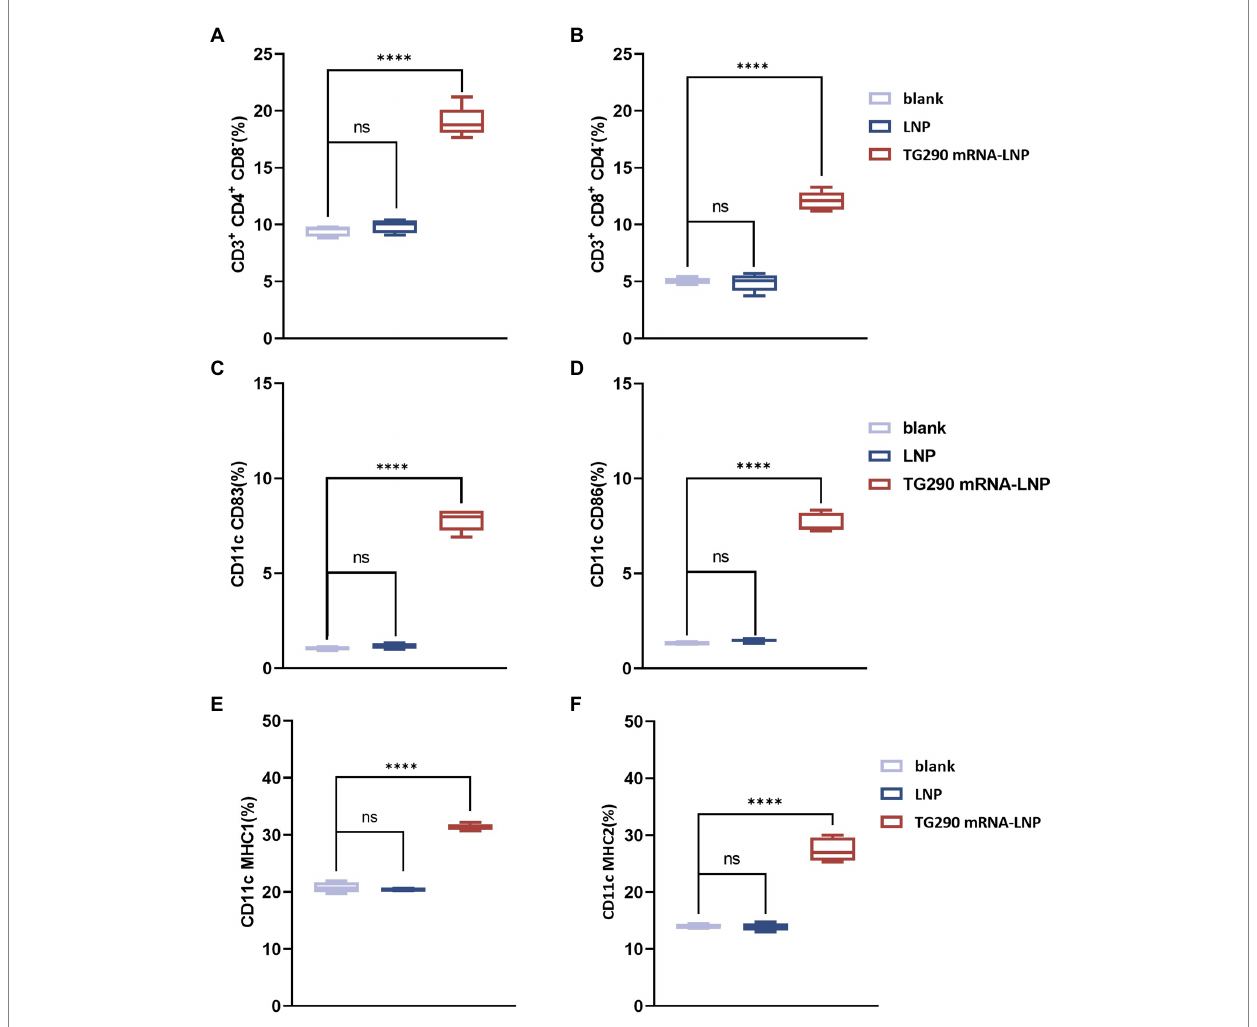
FIGURE 6 Flow cytometry analysis. The percentage of CD4+ (A) and CD8+ T lymphocytes (B) in splenic lymphocytes. The percentage of CD83 (C) and CD86 molecules (D) on splenic DCs. The percentage of MHC-I (E) and MHC-II molecules (F) on splenic DCs. n = 5; **** p < 0.0001, analyzed by One-way ANOVA with multiple comparisons (compare the mean of each group with the mean of every other